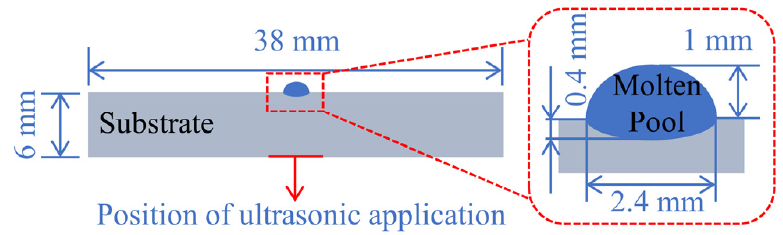
Figure 14. Numerical simulation model for ultrasonic effect.